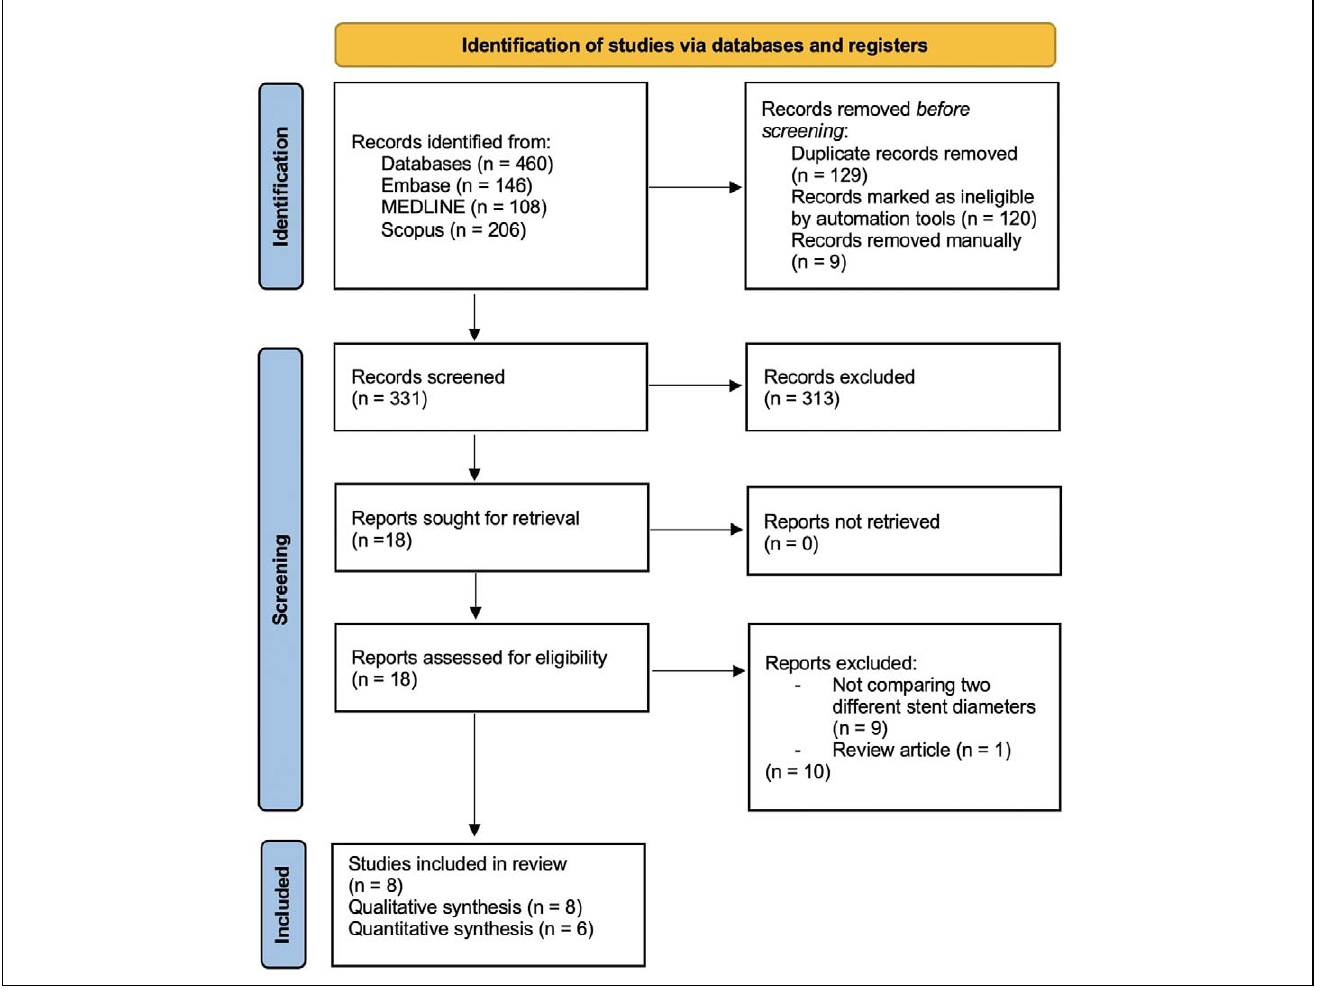
Figure 1. Systematic search and screening based for eligible studies based on the PRISMA 2020